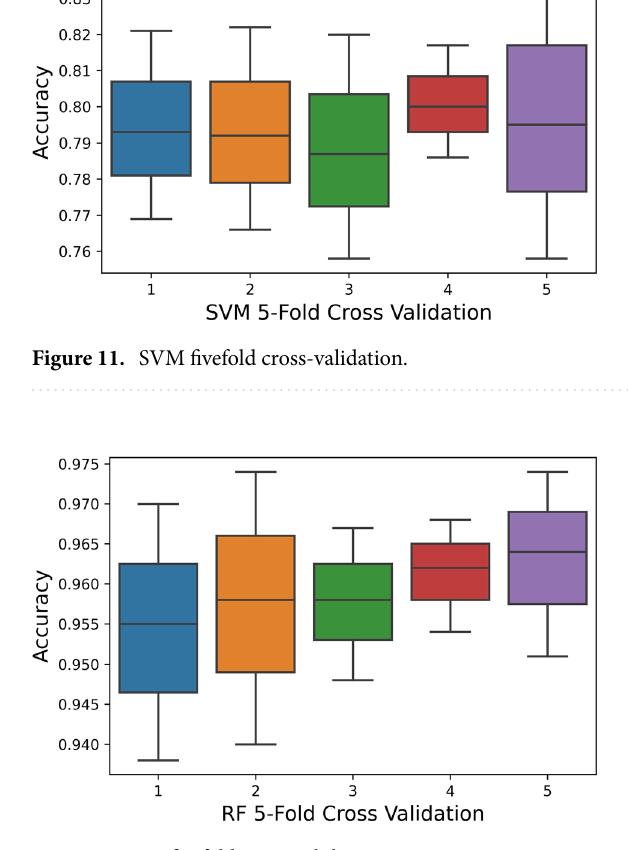
Figure 12. RF fivefold cross-validation.